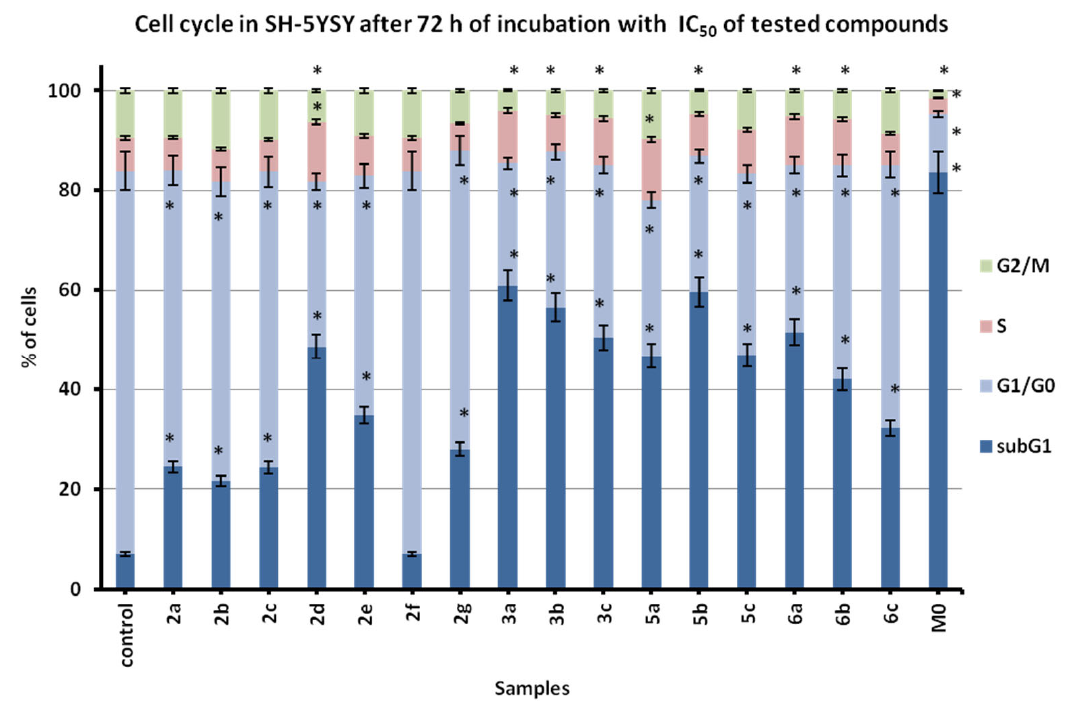
Figure 4. Cell cycle distribution in SH-5YSY cells after 72 h of incubation with doses of IC 50 or 100 µ M, respectively. SubG1 fraction represents apoptotic and dead cells. Results presented as mean from 3 experiments, +/ − SD. Statistical significance indicated by * ; evaluated by t -test, where p < 0.05.